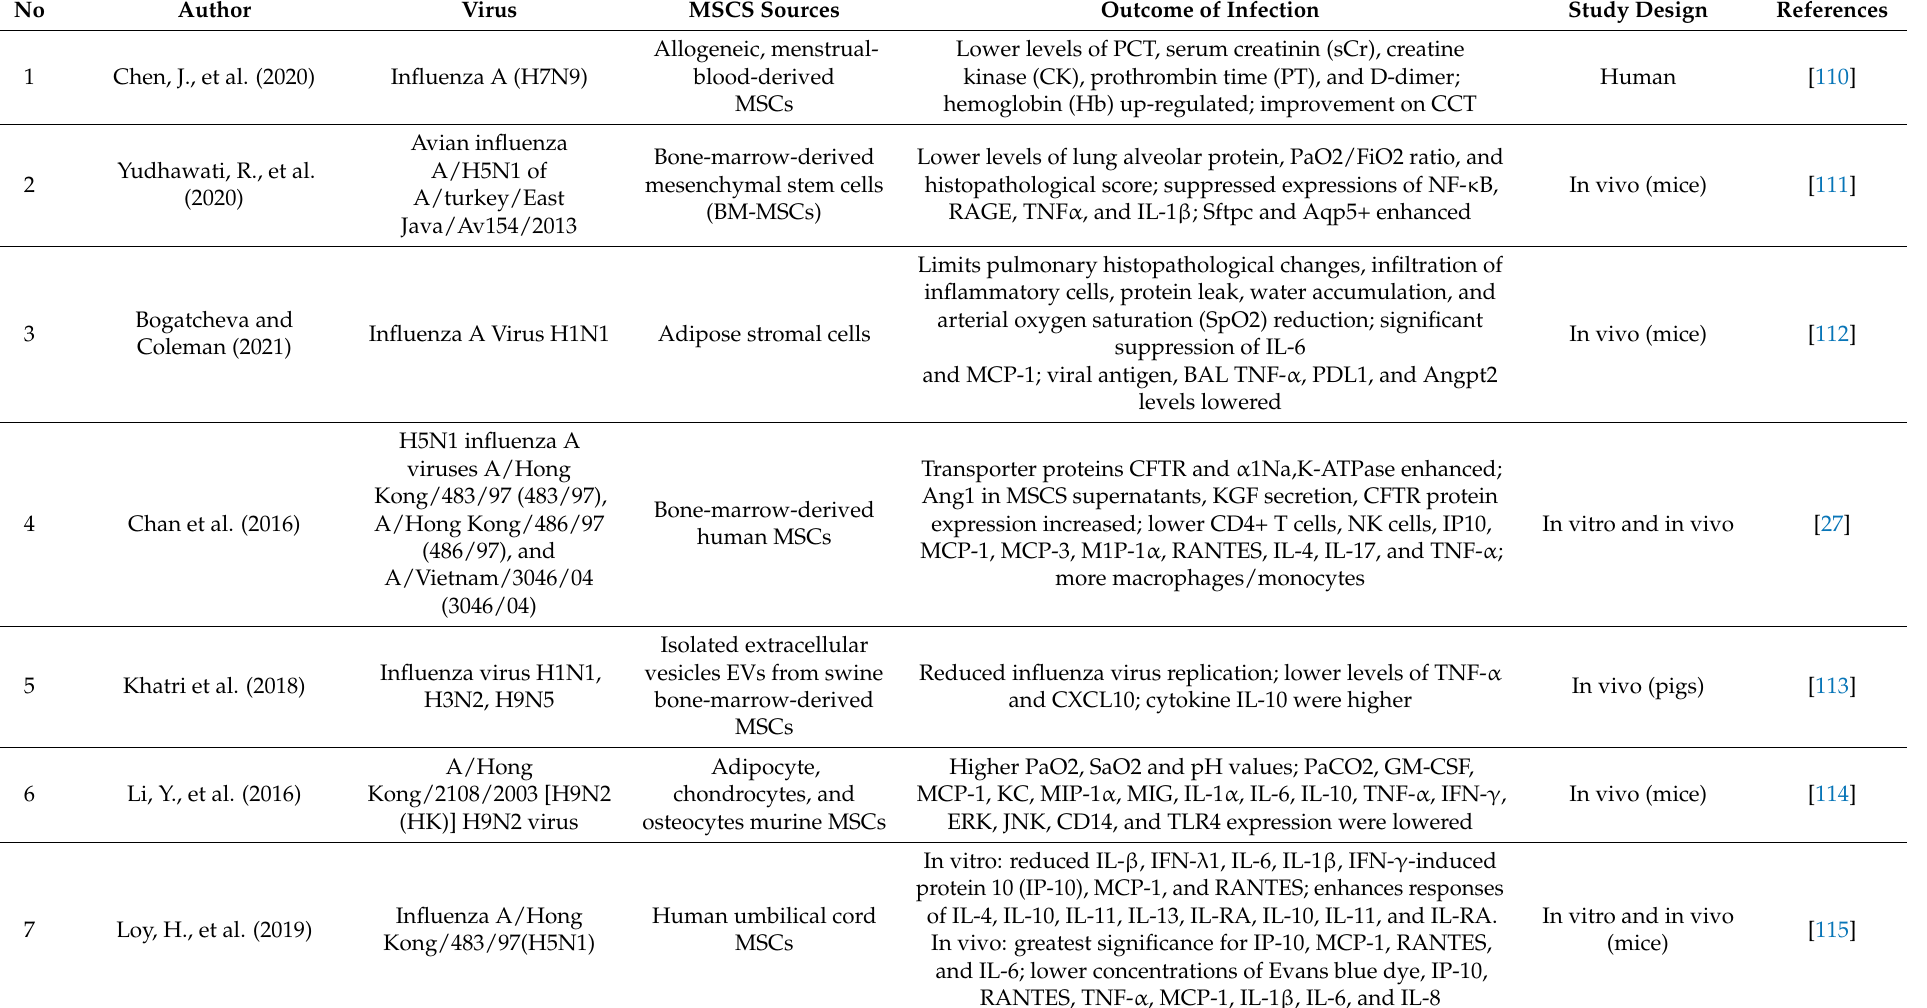
Table 1. The study of MSCs in lung injury induced by different sub-types of influenza